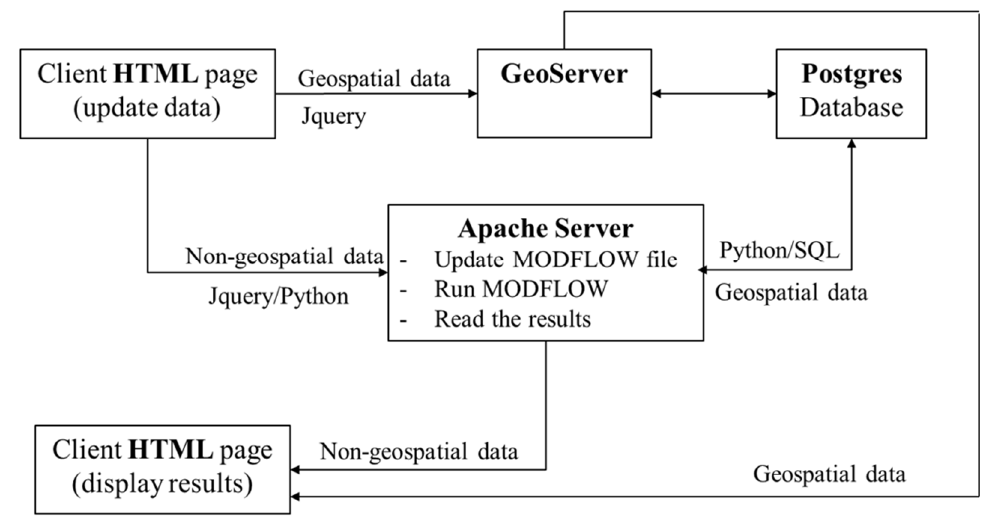
Figure 13. Client–server communication for the GDSS implementation.